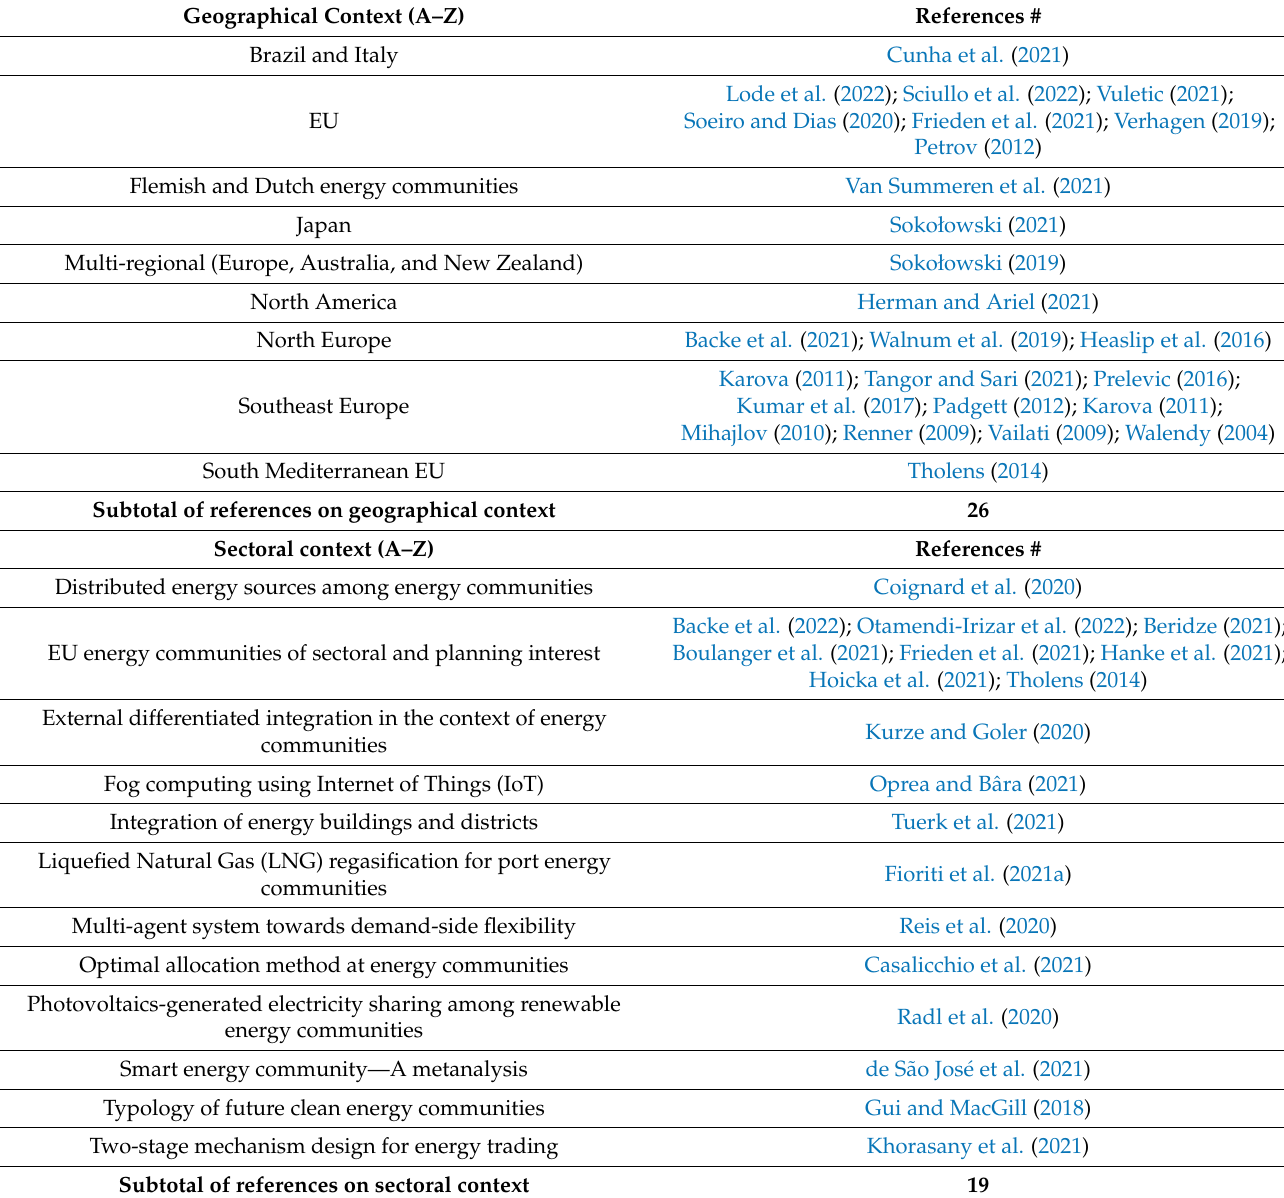
Table 3. Miscellaneous fields of energy communities referring to geographical and to sectoral contexts of analysis (studies are presented in reverse chronological order and in last name of first author alphabetical